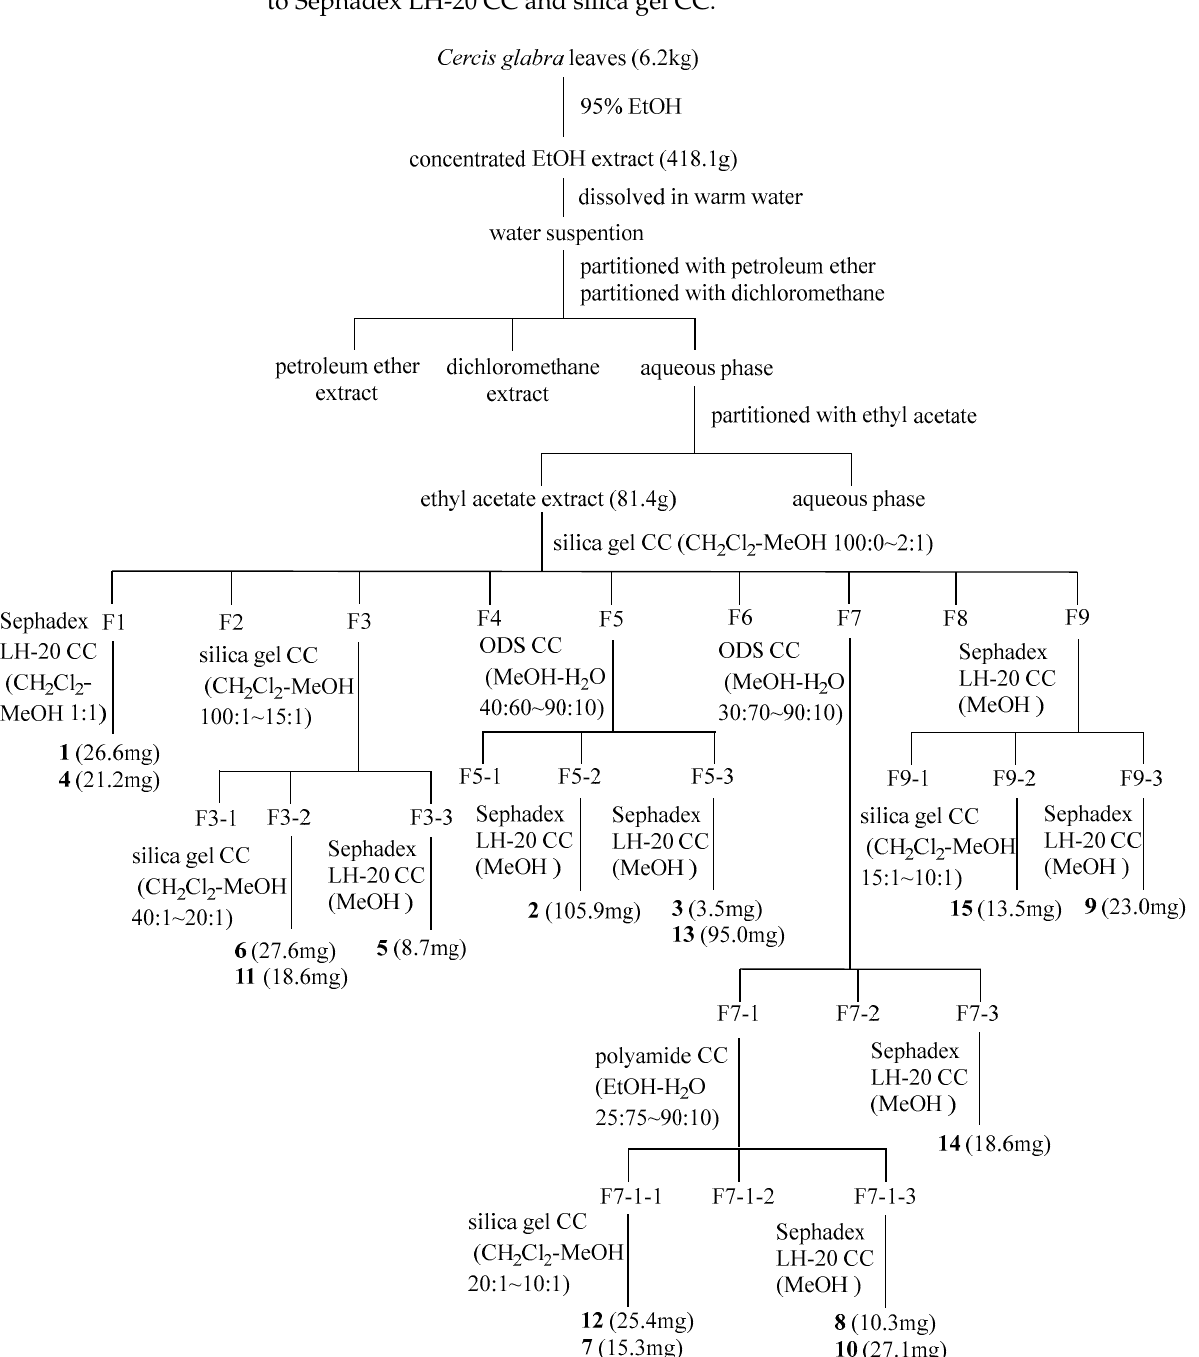
Scheme 1. Extraction, fractionation and purification procedures of chemical constituents from C. glabra leaves.